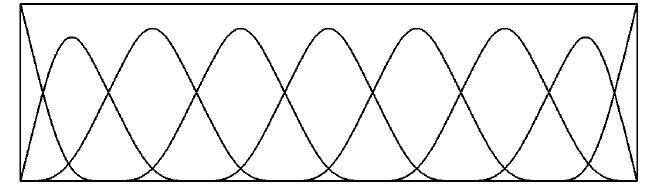
Figure 1. Fup 1 ( x ) basis function trial space.